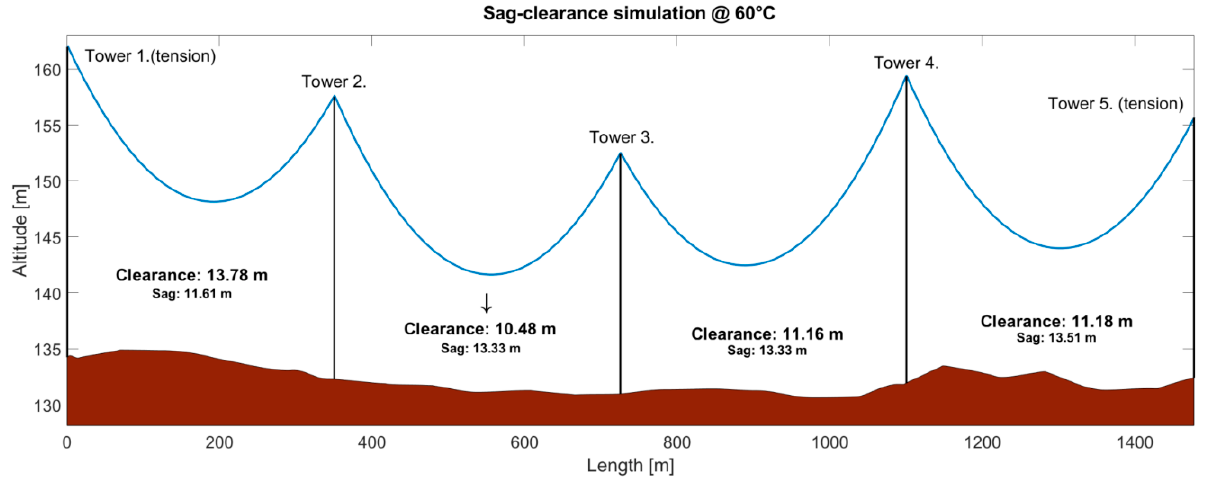
Figure 7. The critical span from the aspect of clearance, equipped with DLR sensor.